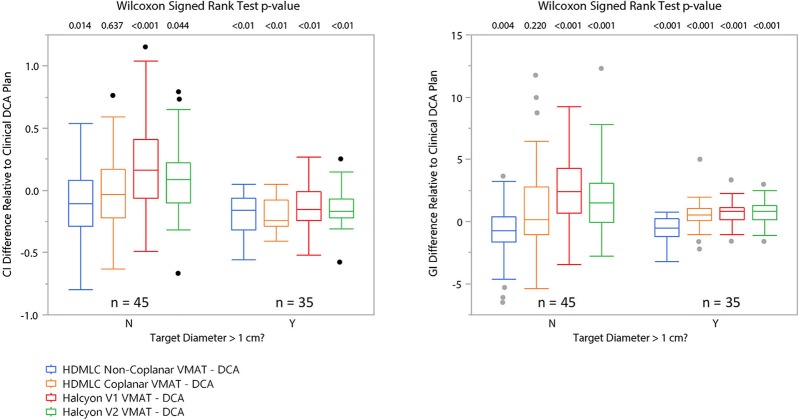
Matched pair comparison of CI and GI between each VMAT technique and the corresponding clinical DCA plans separating cases into two groups by equivalent target diameter. N means target diameter is ≤ 1 cm and Y means target diameter is >1 cm. Wilcoxon signed rank test was used to assess statistical significance of the difference between VMAT plan's CI/GI and those of the clinical DCA plans.